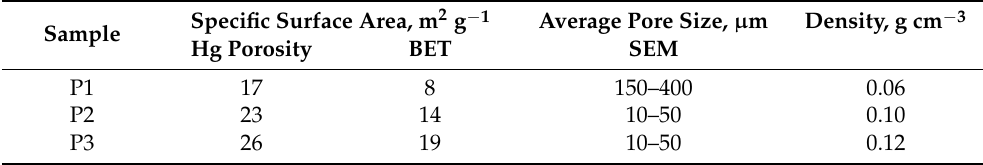
Table 1. Characterization of pectin-based cryogels by nitrogen adsorption.